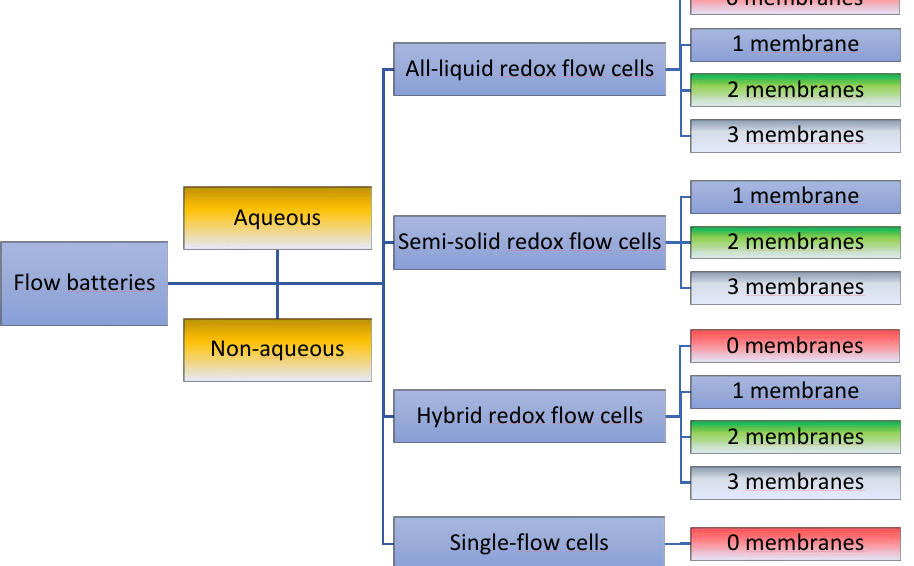
Figure 2. Overview and terminology over general flow cell setups for both aqueous and non-aqueous RFBs, classified by the cell setup and the number of used membranes.